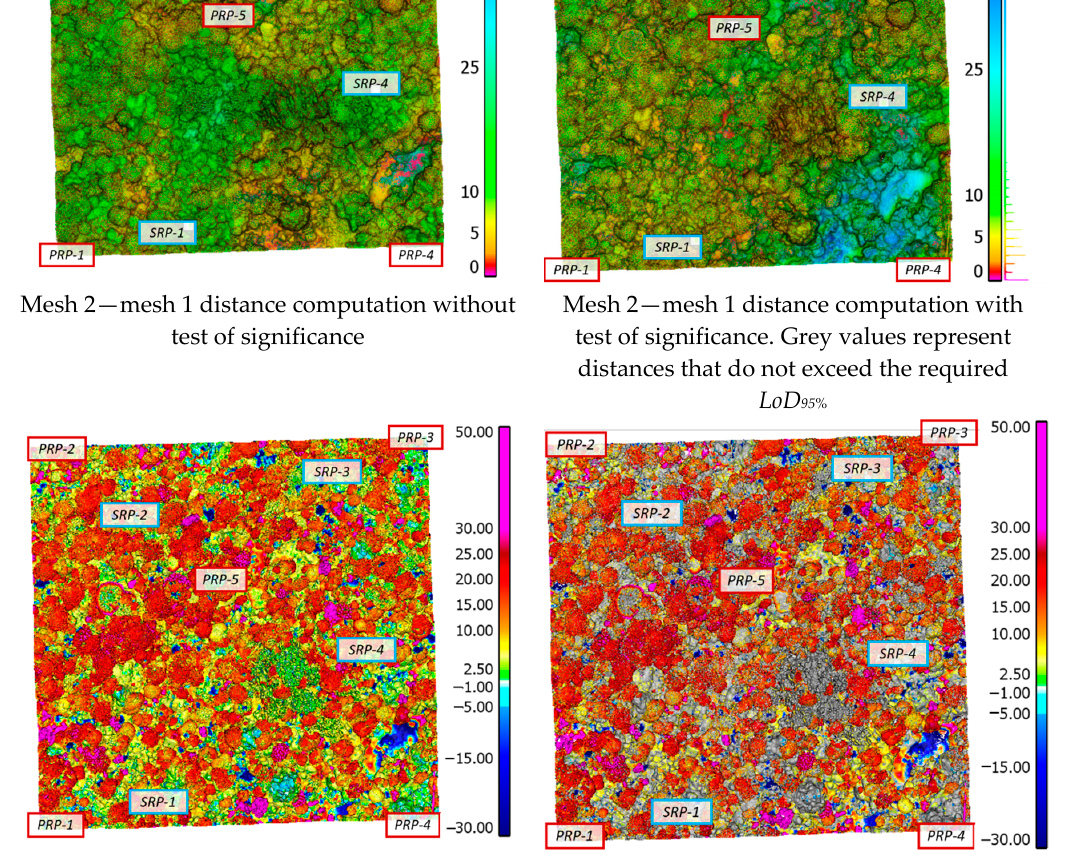
Figure 15. Uncertainty propagation throughout the photogrammetric process and registration of two epochs for significant distance computation. Values are in mm.